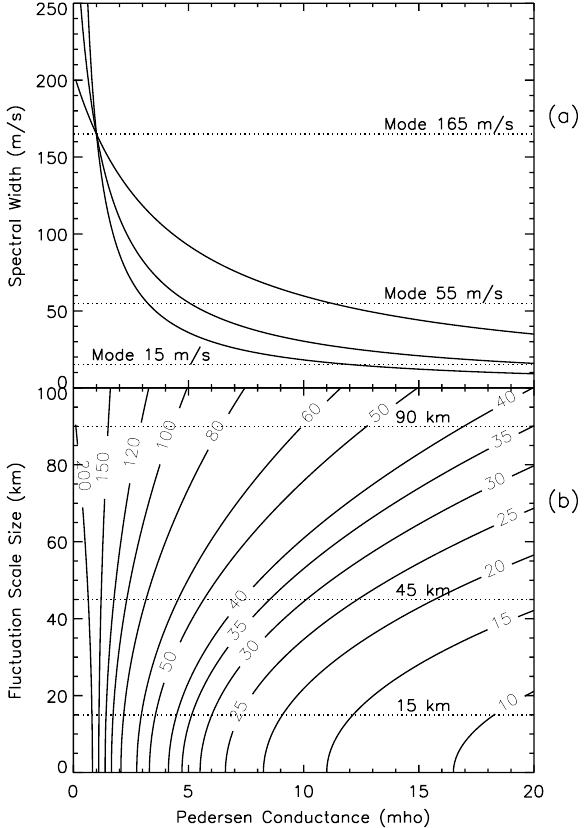
Fig. 10. (a) The three curves show the variation of the spec- tral width with Pedersen conductance for velocity fluctuations on spatial scales of 15km (bottom curve), 45km (middle curve), and 90km (top curve). The calculations assume a most proba- ble spectral width of 165ms − 1 in the polar cap ionosphere where a =2 × 10 − 8 mhom − 2 and 6 p =1mho, (b) The same calculations as in (a), except the contours show the spectral width versus Pedersen conductance for all auroral fluctuation scale sizes between zero and